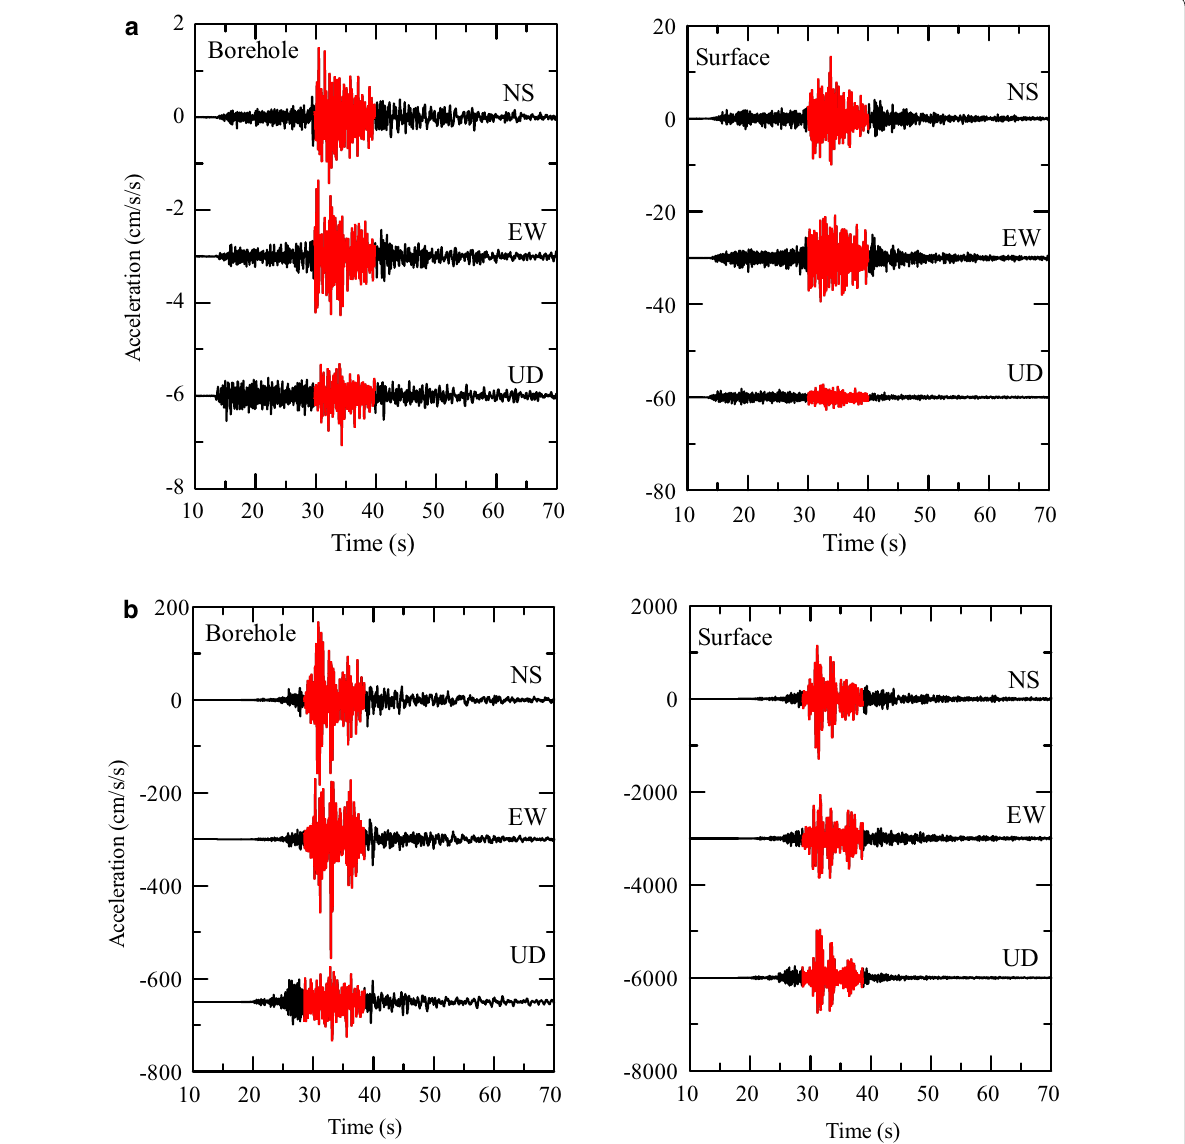
Fig. 4 Example acceleration recordings and S-wave time windows (red portions) selected for evaluation of nonlinear site response at site IBUH01. a Recordings from an event that occurred on Nov 1, 2006, at 23:21 JST (Mj azimuth 120°). b Recordings from mainshock. The borehole and surface recordings are plotted in left and right panels, respectively. The north– = south (NS), east–west (EW), and vertical (UD) components are indicated in each panel. Note that the scale of the vertical axis for surface recordings (right panels) is larger by a factor of 10 with respect to that for borehole recordings. The recordings for the mainshock are shifted to the right by 4 s to match with the S-wave arrivals on the weak-motion recordings in panel